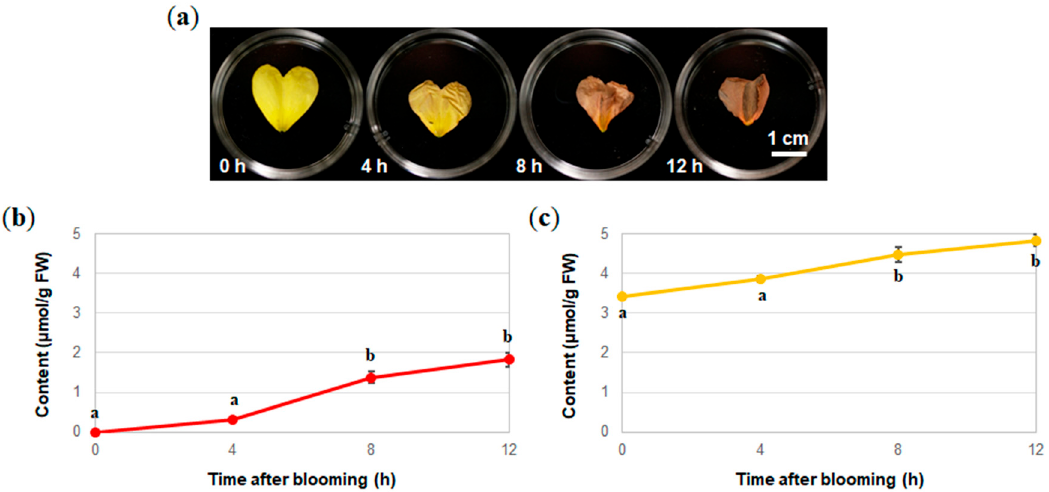
Figure 6. Changes in color and flavonoid components of the petals of O. laciniata during senescence. ( a ) Petal color at each stage, ( b ) change in the Cy3G ( 1 ) content, and ( c ) change in the isosalipurposide ( 3 ) content. The data shown are the means ± SE of three replicates ( n = 3). Where no error bars are shown, the SE was too small to determine. Different letters indicate significant differences according to Tukey’s HSD test ( p < 0.05).